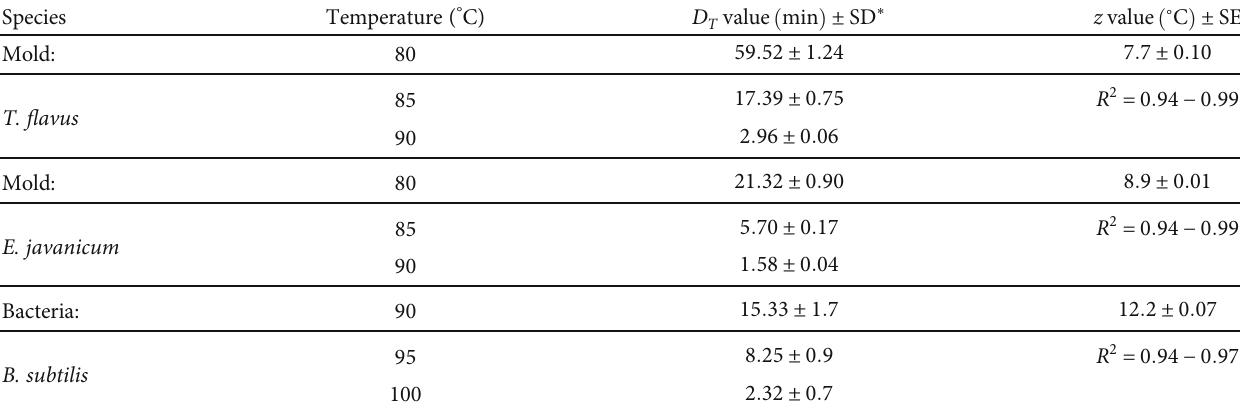
∗ D values shown are average of twoexperiments ± standarddeviation . Table 2: The e ff ect of pH change on the heat resistance of spores of Talaromyces fl avus and Eupenicillium javanicum molds and Bacillus subtilis bacteria in guava juice.